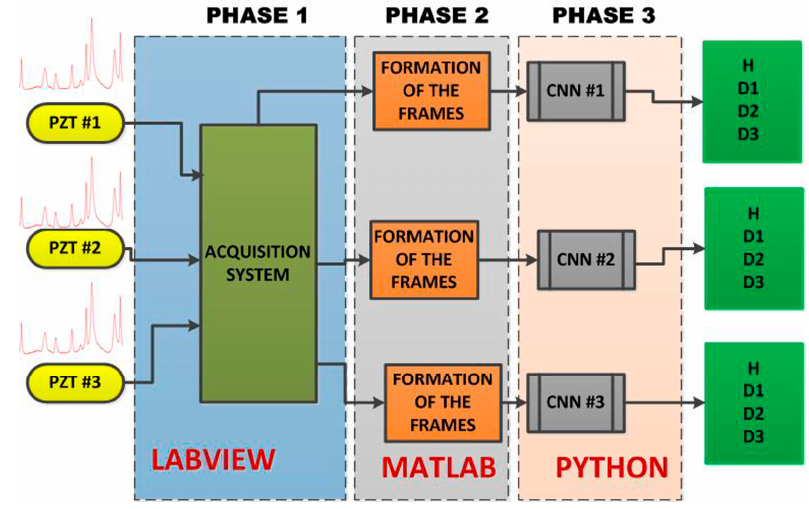
Figure 2. Developed framework for structural damage detection, based on the CNN algorithm, including all three phases.